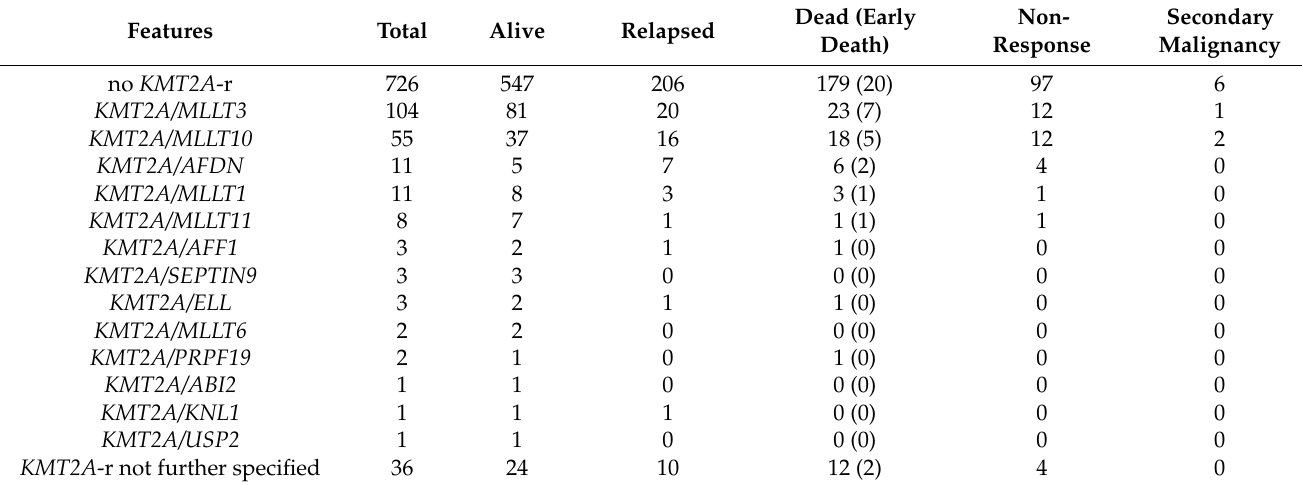
Table 2. Outcome of Pediatric AML Patients with Specific KMT2A